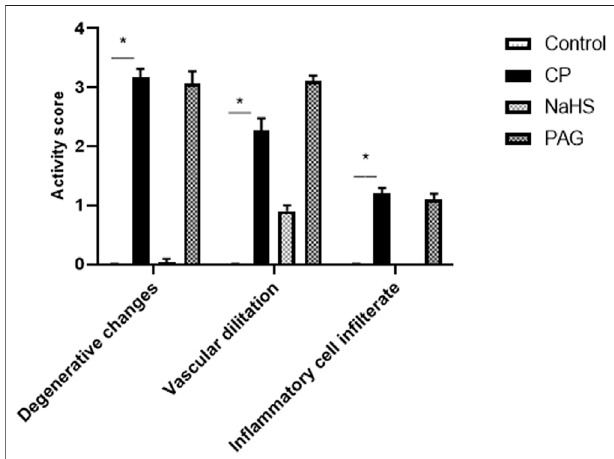
FIGURE 3 | Effect of NaHS and PAG on the severity of histopathological lesions in CP-induced hepatotoxicity in rats. All parameters were represented as mean score. Kruskal – Wallis and then Dunn ’ s test was applied for comparison. * is signi fi cantly different from control where p < 0.05. CP; cyclophosphamide, PAG; DL-propargylglycine.